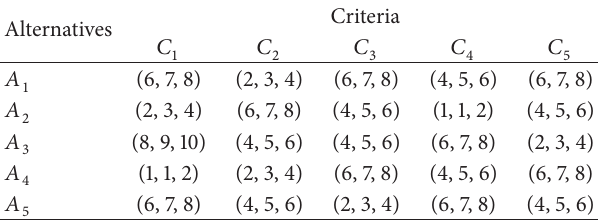
Table 7: Individual fuzzy decision matrix of DM 5 . Alternatives